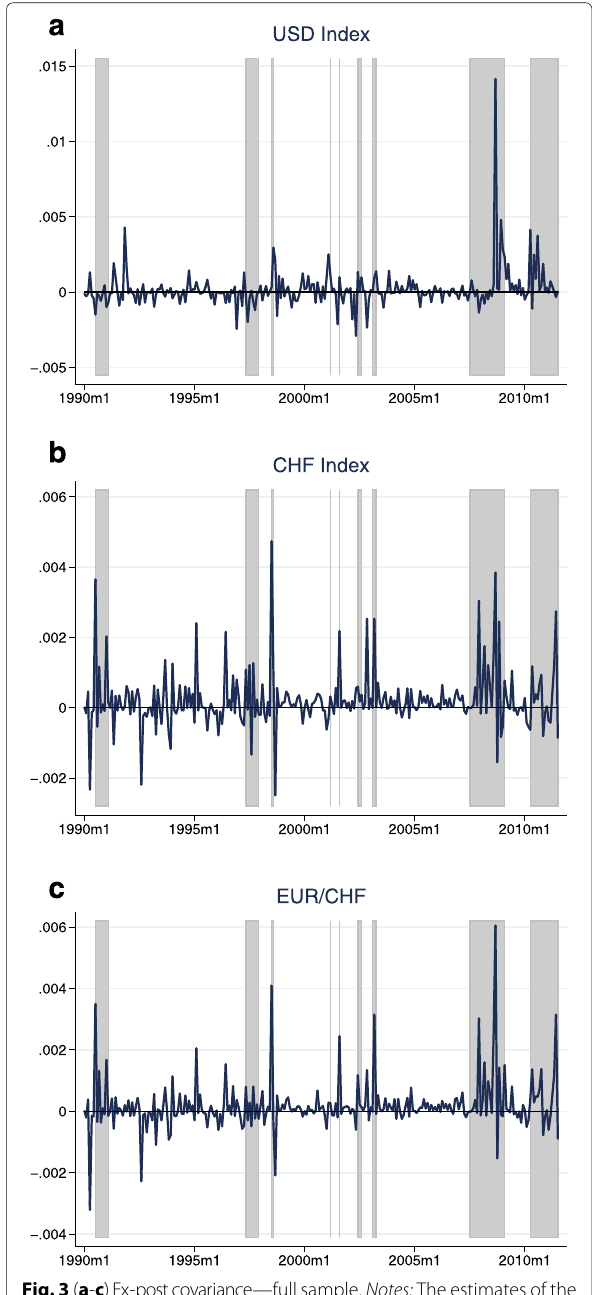
Fig.3 ( a - c )Ex-postcovariance—fullsample. Notes: The estimatesof the ex-postcovariancearecalculatedastheproductoftheresidualsofthe zero stage regressions: (cid:12) Cov t ˆ (cid:7) e t + 1 are the residuals in Eqs. (6) and (7). The zero stage regressions are estimated using the full sample, which consists of 259